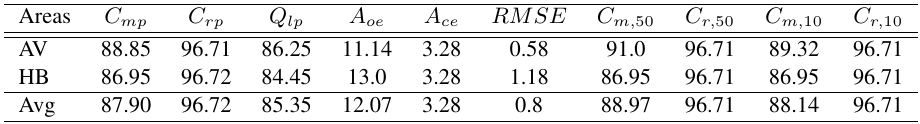
Table 2. Building detection results: pixel-based evaluation for the Aitkenvale ( AV ) and Hervey Bay ( HB ) data sets in percentage.